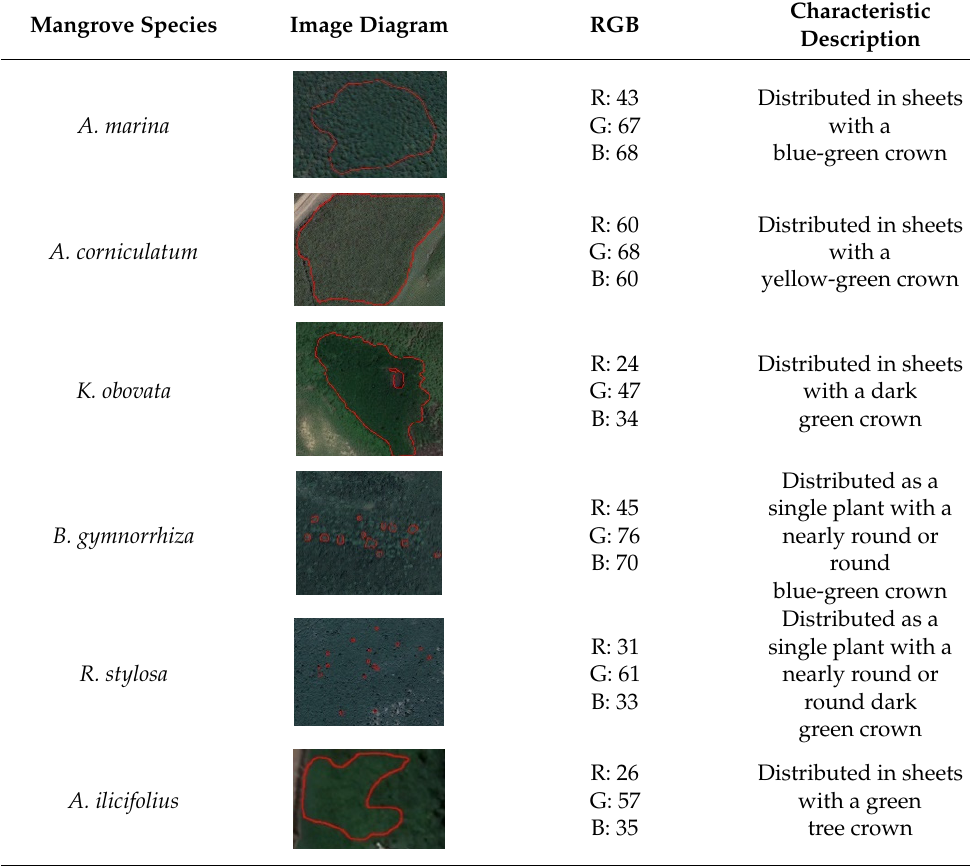
Table 1. Feature descriptions of mangrove plants in Google Earth images. Mangrove Species Image Diagram RGB